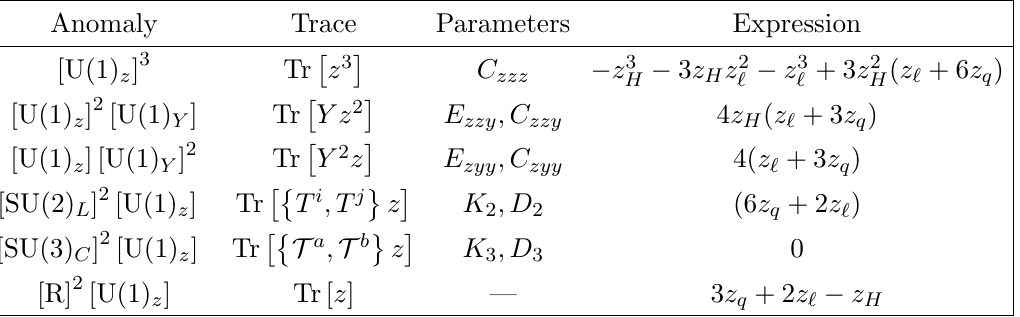
Table 2. The di(cid:11)erent possible gauge anomalies, together with the corresponding traces, the corresponding GS parameters and the traces’ algebraic expressions in terms of the charges z q ; z ‘ and z H . The table is expressed in terms of the generators T i of SU(2) L , T a of SU(3) c , Y of U(1) Y and z of U(1) z . In the (cid:12)nal anomaly we have written R to represent the general relativity gauge